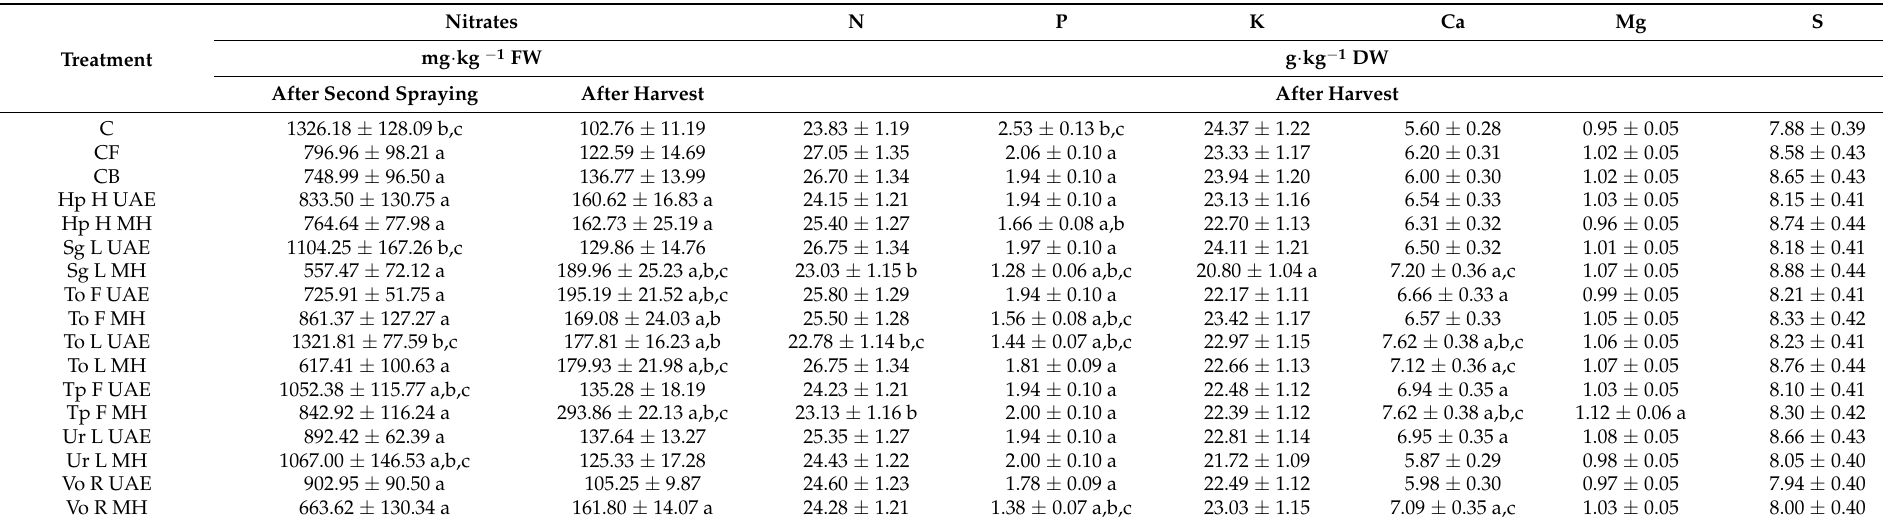
Table 4. Effect of the foliar application of the botanical extracts on the nitrates content in leaves after second spraying and cabbage head after harvest ( n = 4, mean ± SD), and macroelements content of cabbage head after harvest ( n = 3, mean ±